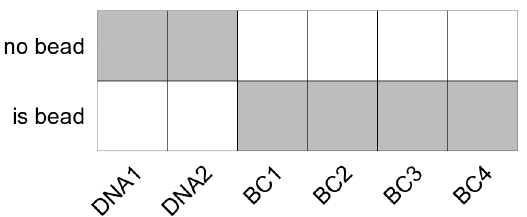
Figure 18. Schematic of the debarcoding scheme used by ‘CATALYST‘’s ‘normCytof()‘ function to identify bead events. Rows correspond to barcodes, columns to DNA and bead channels. Each barcode is either positive (grey) or negative (blank) for a given channel; cells (barcode 11000...) are positive for DNA and negative for bead channels, bead events (barcode 00111...) are negative for DNA and positive for bead